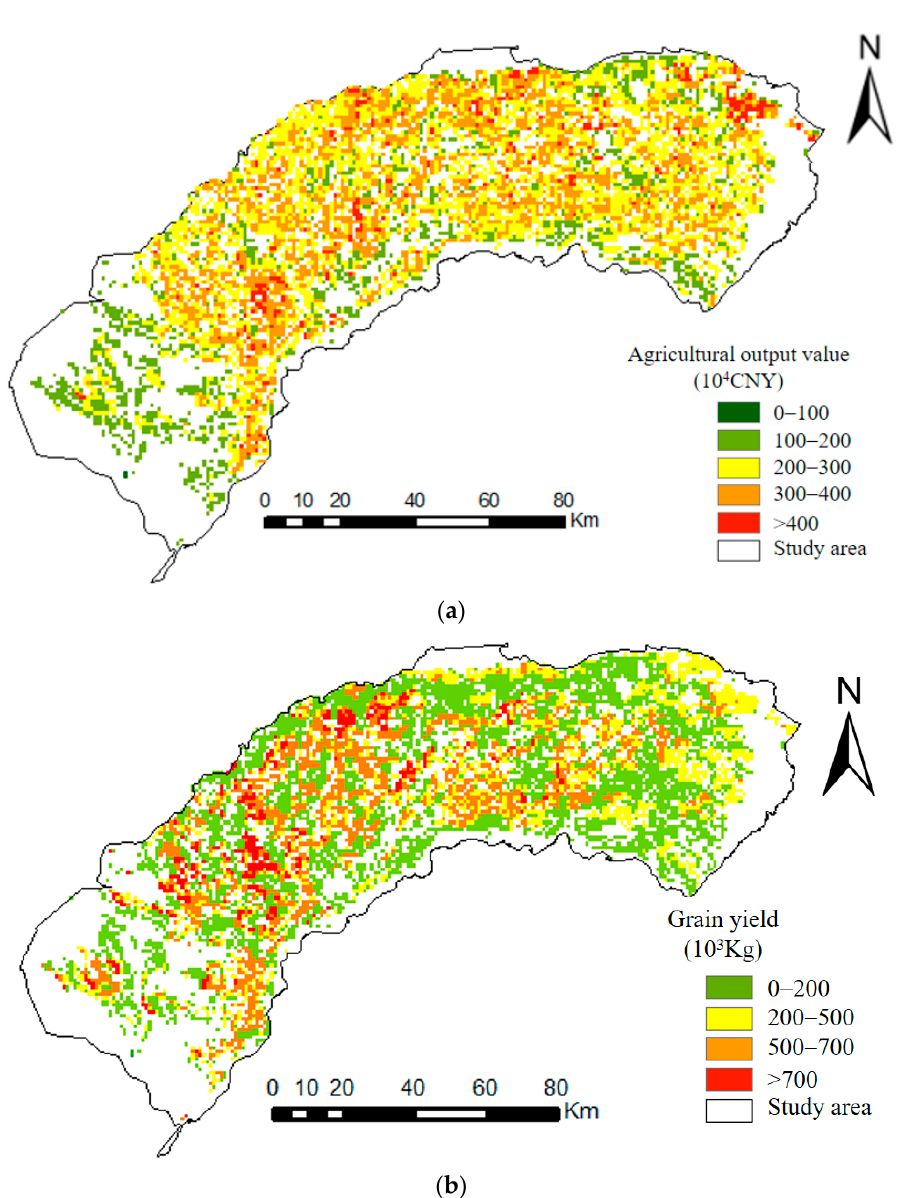
Figure 7. Spatial data of agricultural output value and grain yield in HID: ( a ) Agricultural output value; ( b ) grain